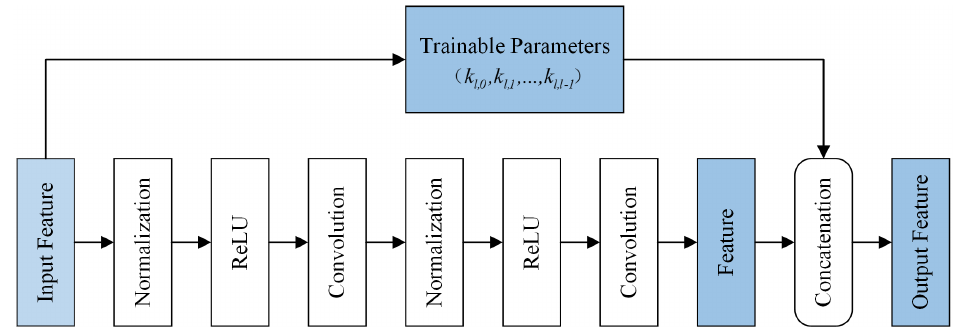
Figure 4. Improved dense block